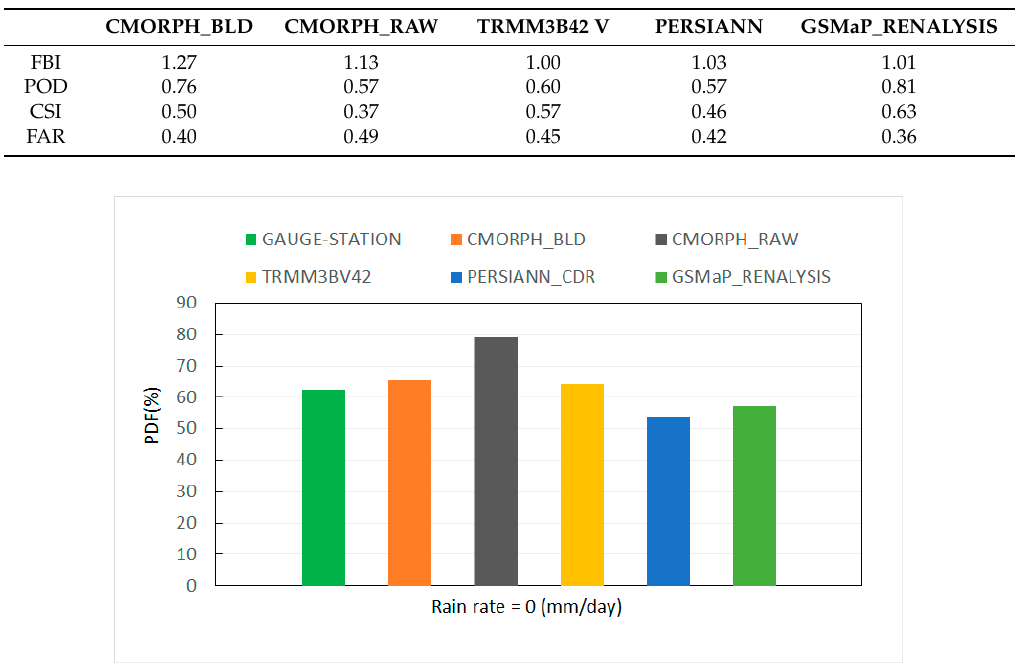
Figure 8. Probability density function of the daily rainfall events with different intensities.